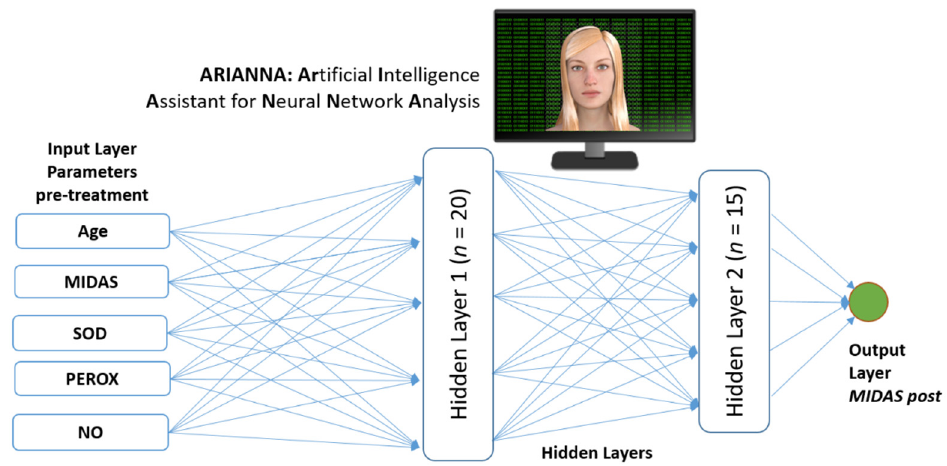
Figure 1. Schematic representation of the artificial neural network used in this study with five variables assessed pre-treatment as input and one variable assessed post-treatment (MIDAS) as output ( n represents the number of units determined for each hidden layer).